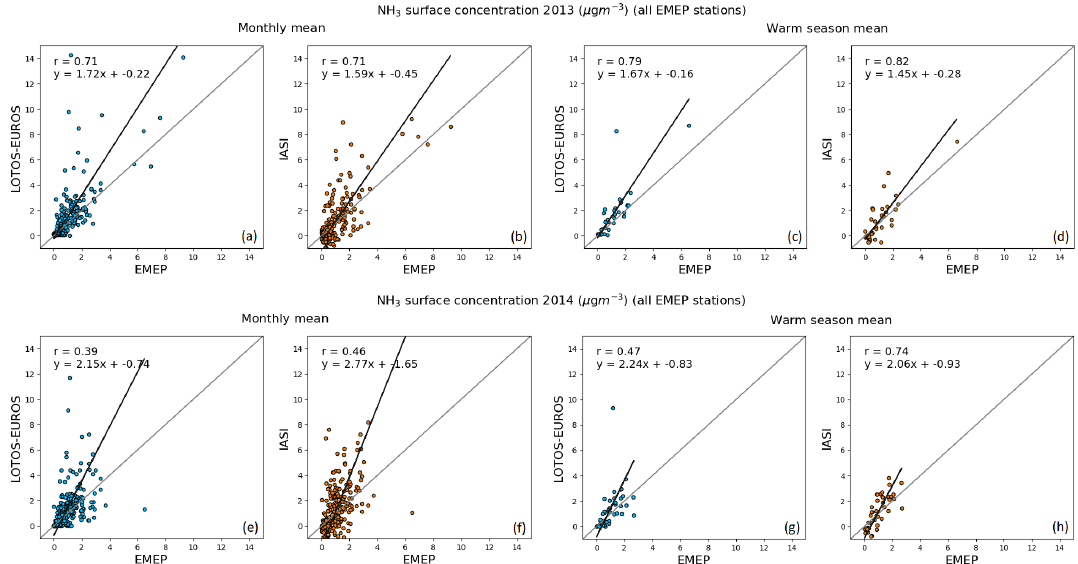
Figure 4. Comparison of the monthly mean (a, b, e, f) and warm season (April–September) mean (c, d, g, h) NH 3 surface concentrations measured by the EMEP stations and the corresponding NH 3 surface concentrations from LOTOS-EUROS (blue dots) and inferred from IASI (orange dots) in 2013 (top) and 2014 (bottom).